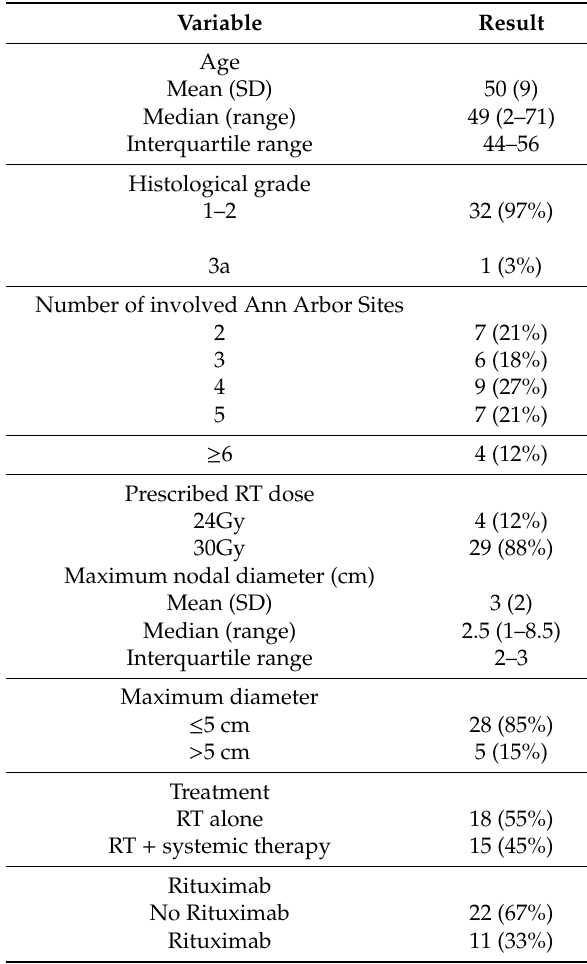
Table 1. Demographic